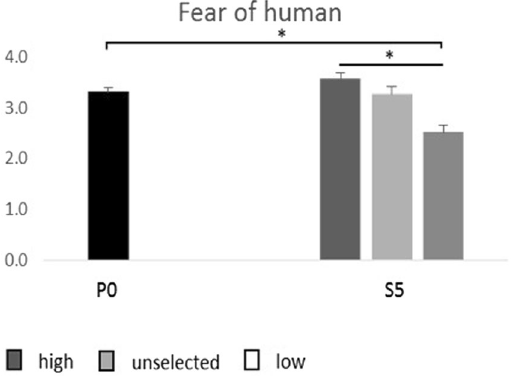
Figure 1. Average fear scores ( + / − SEM) in the parental generation (P0) and in the three selection lines in the fifth selected generation (S5). The fear score was obtained through transformation of behavioural recordings in a fear-of-human-test to a scale ranging from 1–5, where 1 signifies the least fearful reactions. * P < 0.05.